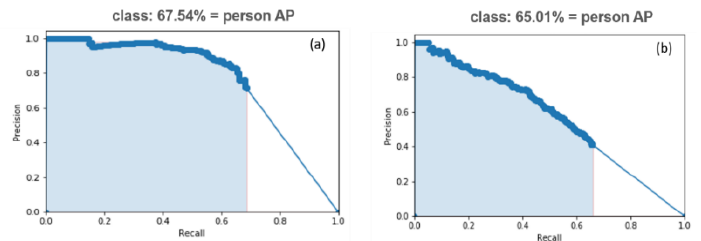
Figure 14. The AP score of PR curve for gait classifier trained on ( a ) FLIR ADAS dataset, and ( b ) KAIST dataset.